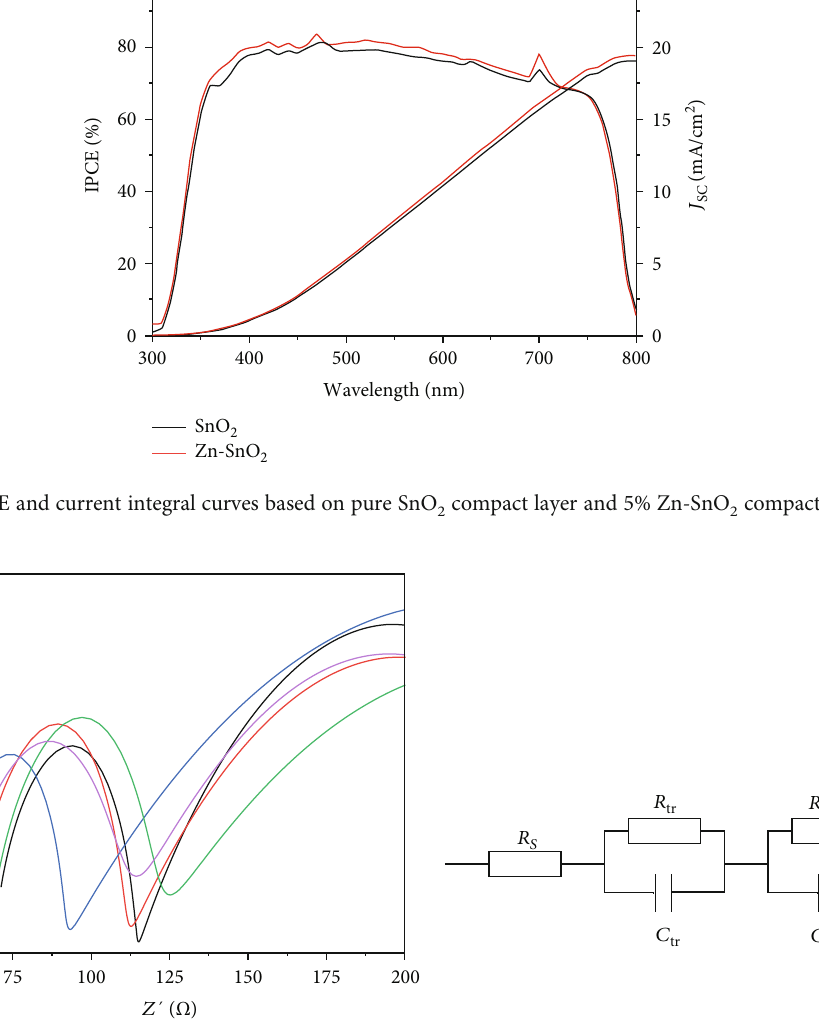
compact layer; (b) equivalent circuit to fi t the 2